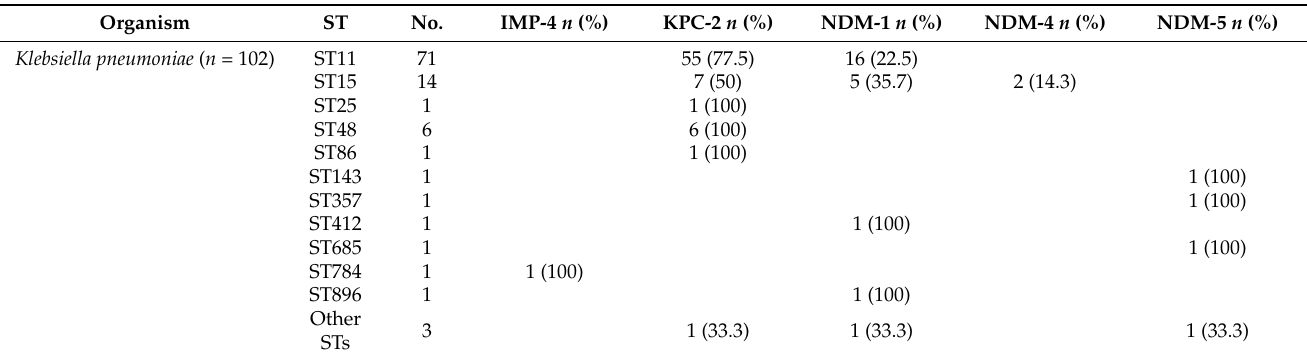
Table 2. Carbapenemase Distribution Determined by CRE